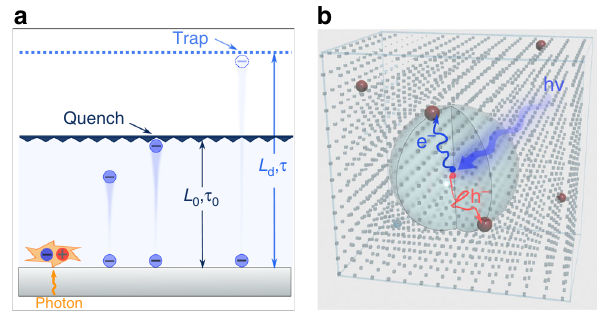
Fig. 1 Concept of diffusion-quenching models. a 1D diffusion-quenching structure; carrier funneling process occurs at the interface between the active material and carrier extraction layer. b Con fi guration of 3D bulk diffusion-quenching model, with quenching sites (brown spheres) dispersed inside the bulk of material. Diffusion processes of electrons (red curve) and holes (blue curve) occur in all three dimensions (over area of semitransparent large